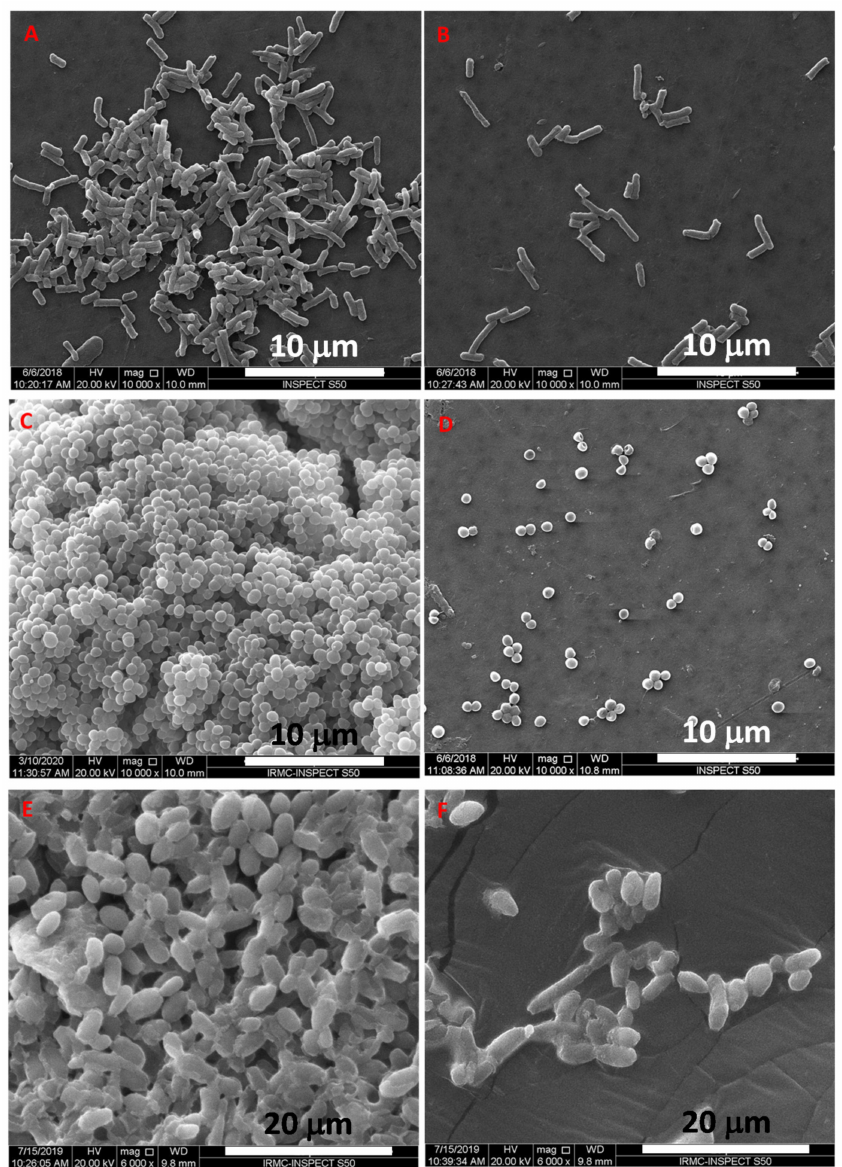
Figure 11. SEM images showed significant depletion in MDR-PA ( B ), MRSA ( D ), and C. albicans ( F ) biofilm formation, respectively, at 7.80 µ g/mL of TCE-Ag-3 NPs after 24 h as compared to untreated experiment ( A , C , E